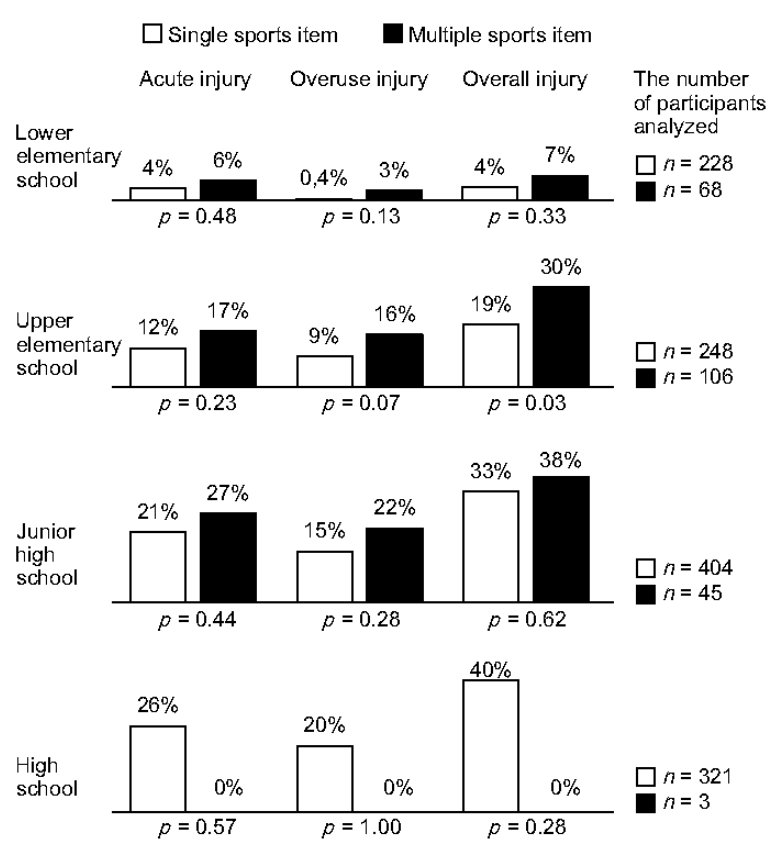
Figure 2. Proportions of those with sports-related injuries compared with single and multiple sports items. Overall injuries included acute and overuse injuries.